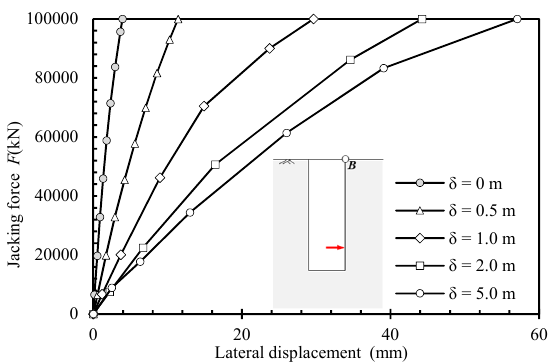
Figure 8. Load–lateral displacement curves at the ground surface with different thicknesses of the disturbance ring.